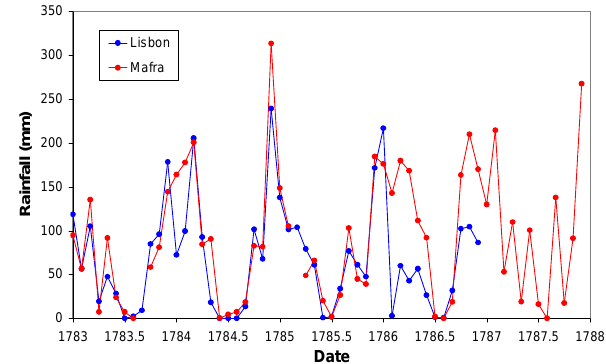
Figure 7. Monthly rainfall totals in Lisbon and Mafra from 1783 to 1789. Fig. 7. Monthly rainfall totals in Lisbon and Mafra from 1783 to 1789.